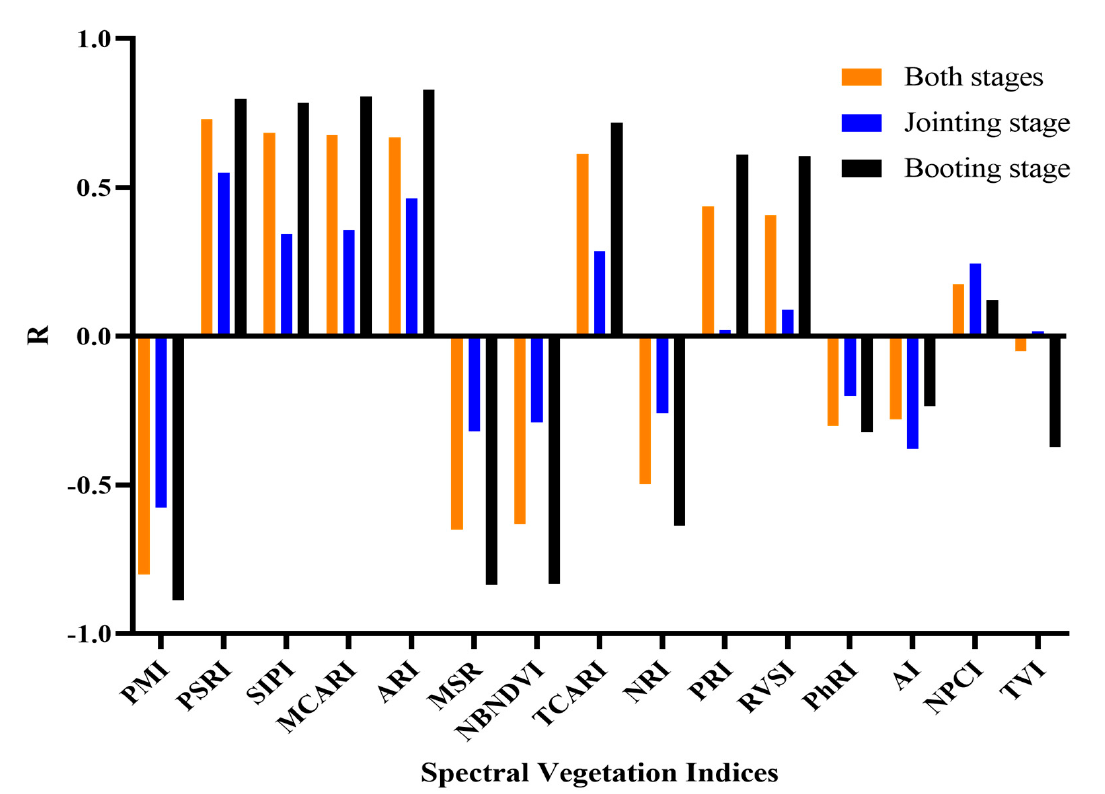
Figure 5. Response of spectral vegetation indices to DS at both and single growth stages.